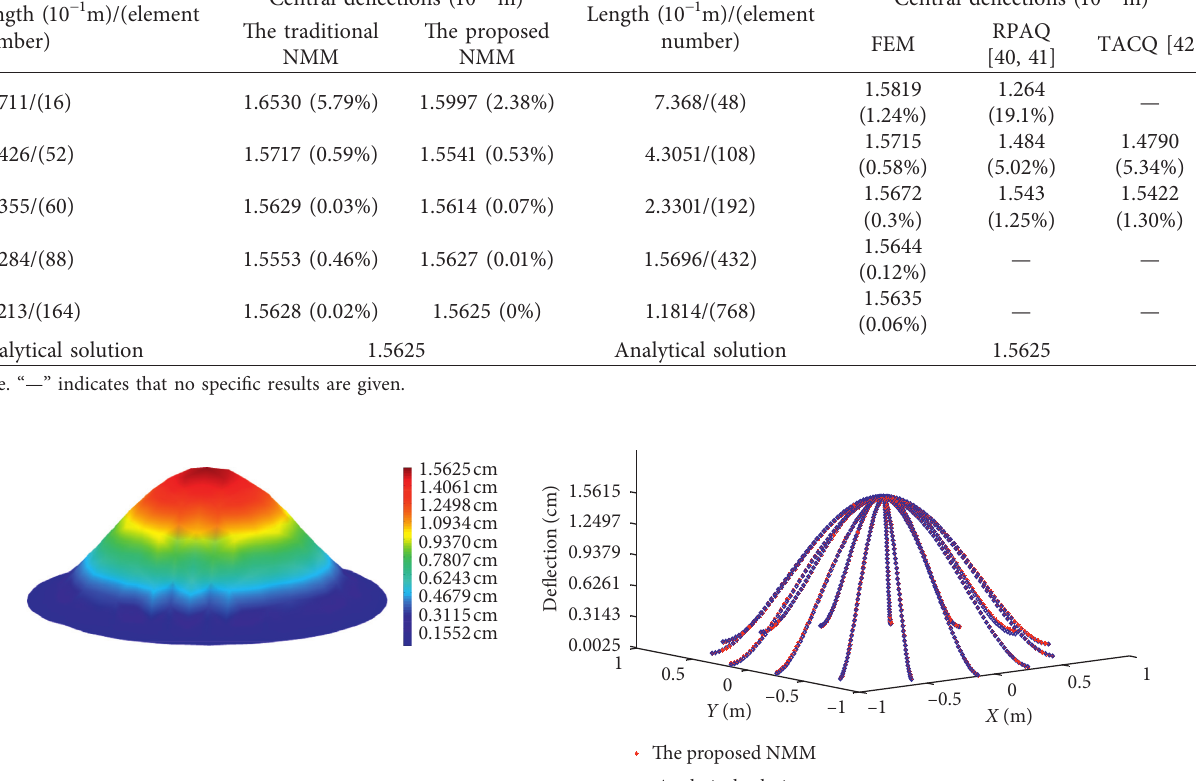
Table 1: Central deflections of a clamped circular plate under distributed load calculated with different methods. Length (10 − 1 m)/(element